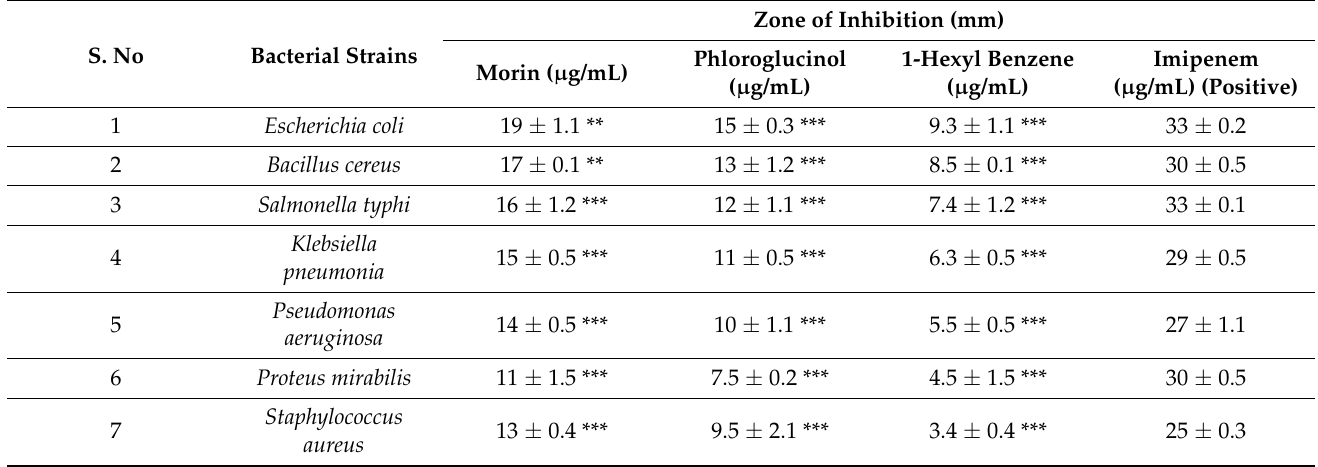
Table 4. Zone of inhibitions of the morin against various bacterial strains.